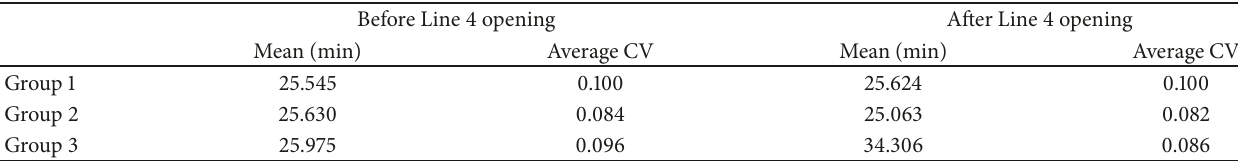
Table 2: Mean and average CV of commuting travel